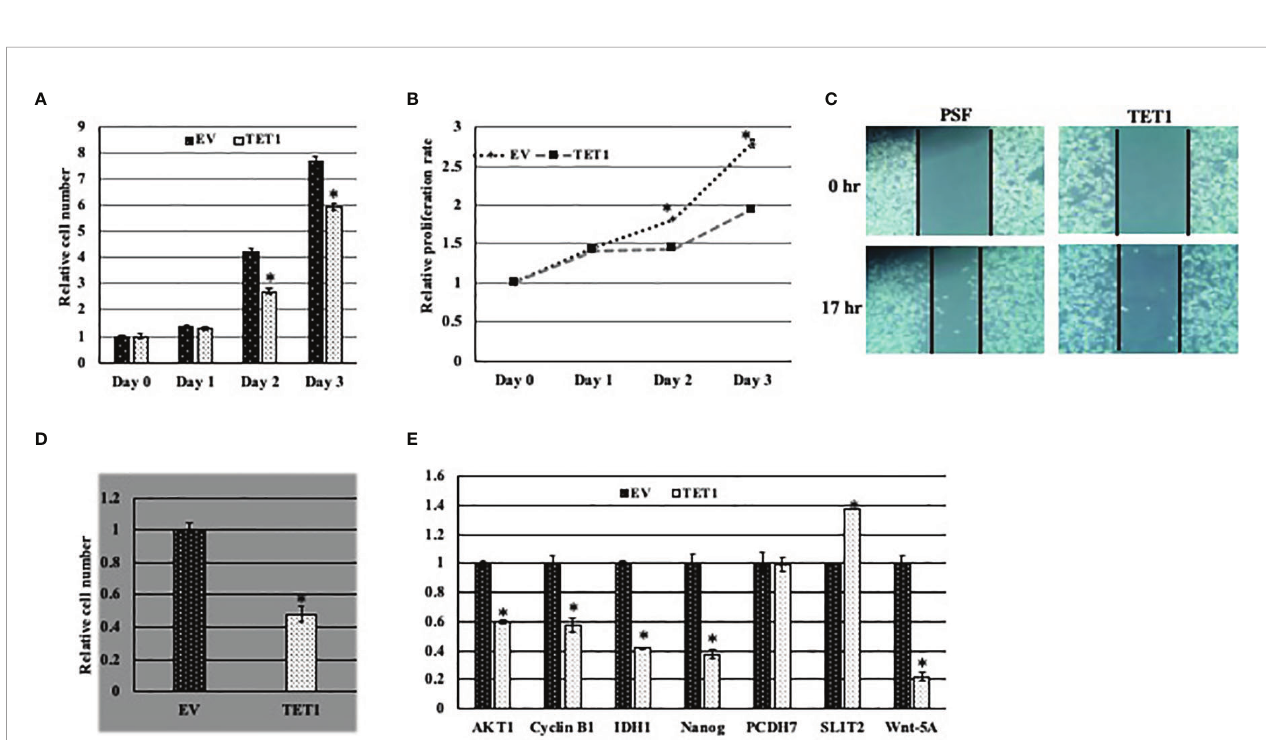
FIGURE 5 | Effect of TET1 overexpression on MDA MB231 cell phenotypes. Representative graph showing the relative proliferation rate of TET1 overexpressing cells compared to control cells using cell count assay (A) and XTT assay (B) . Cell growth was monitored over three days and cell growth is blotted in reference to day 0. (C) . Representative images showing the migration capability of TET1 overexpressing cells in comparison to control cells using wound healing assay. Cell migration was monitored after 17 hrs. (D) . Representative statistical analysis of the survival rate of TET1 overexpressing cells in comparison to control cells using cell survival assay. (E) Relative qRT-PCR results showing the expression level of different TET1 target genes in MDA MB231 cell line. mRNA levels are shown after normalization to the level of the housekeeping gene hUBC and relative to mRNA level of each gene in MDA MB231 infected with EV. All experiments were done in triplicates. Bars represent SEM. * indicates that p-value is